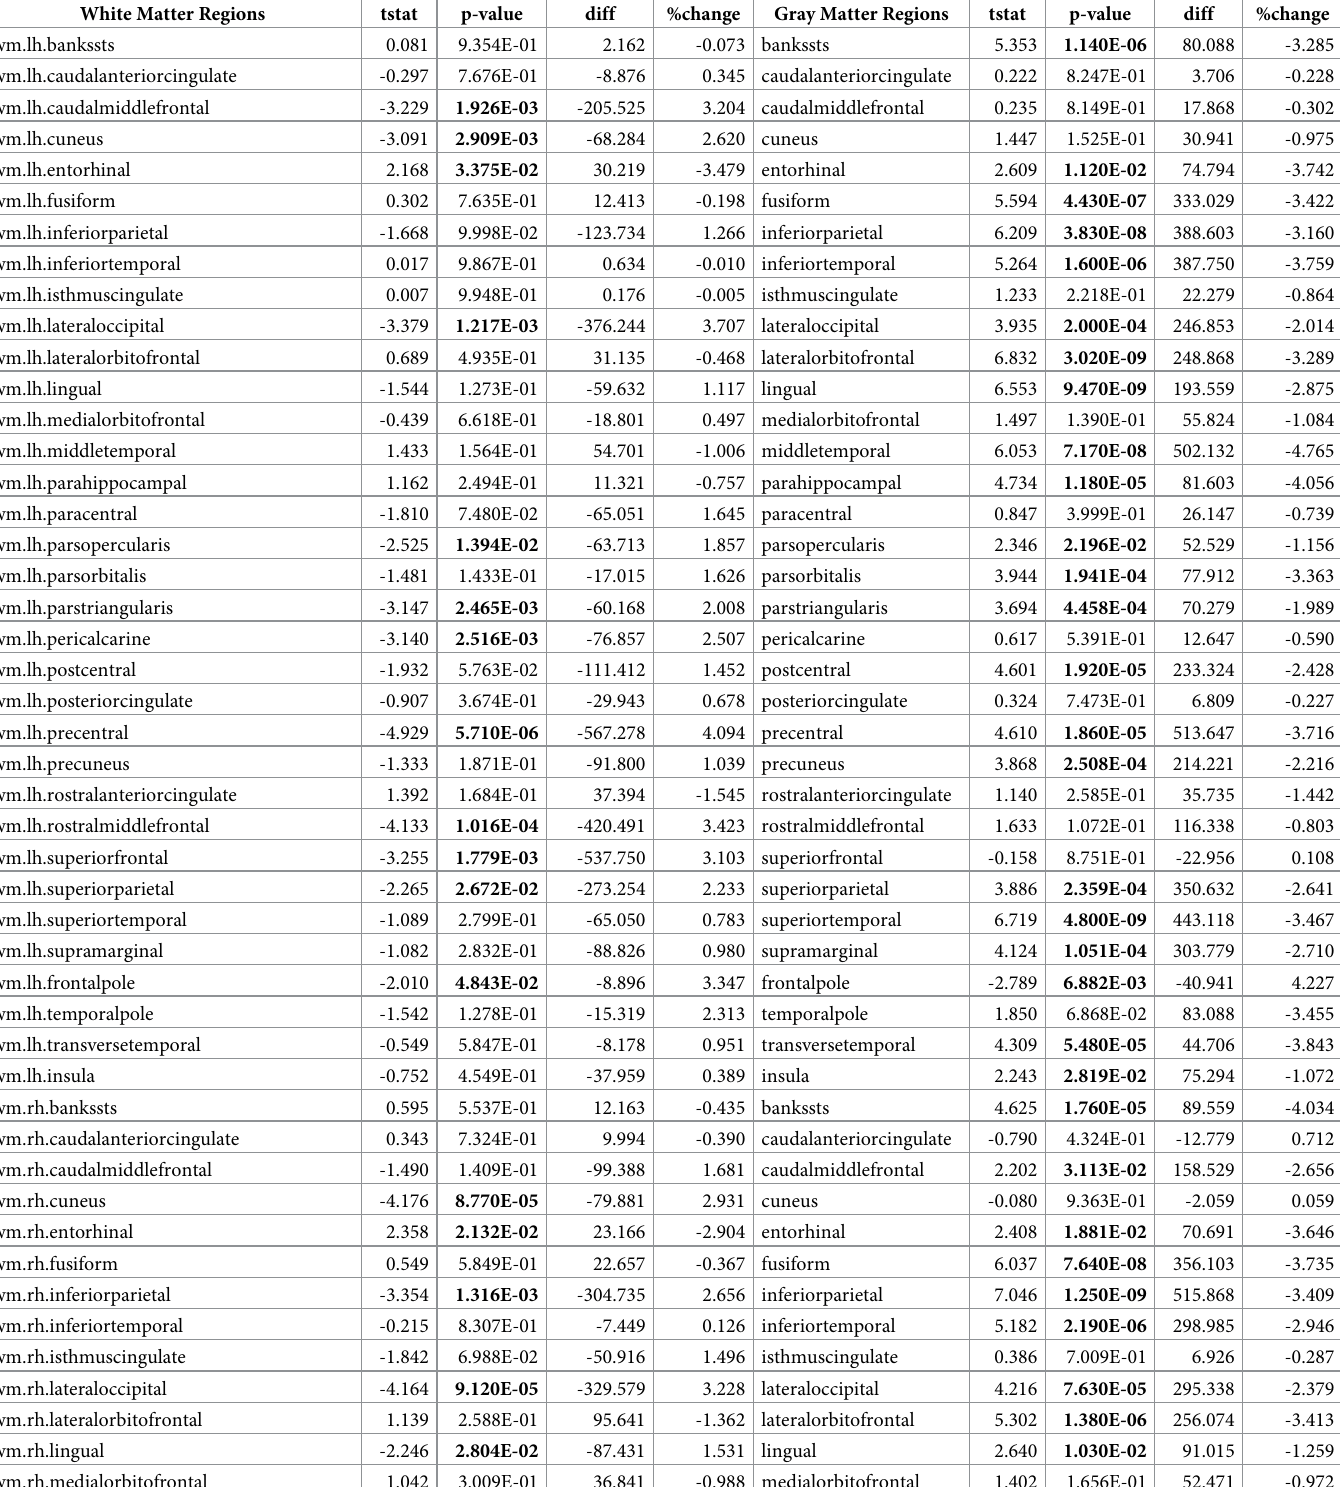
Table 5. Volumetric comparisons between day 7 and during anesthesia